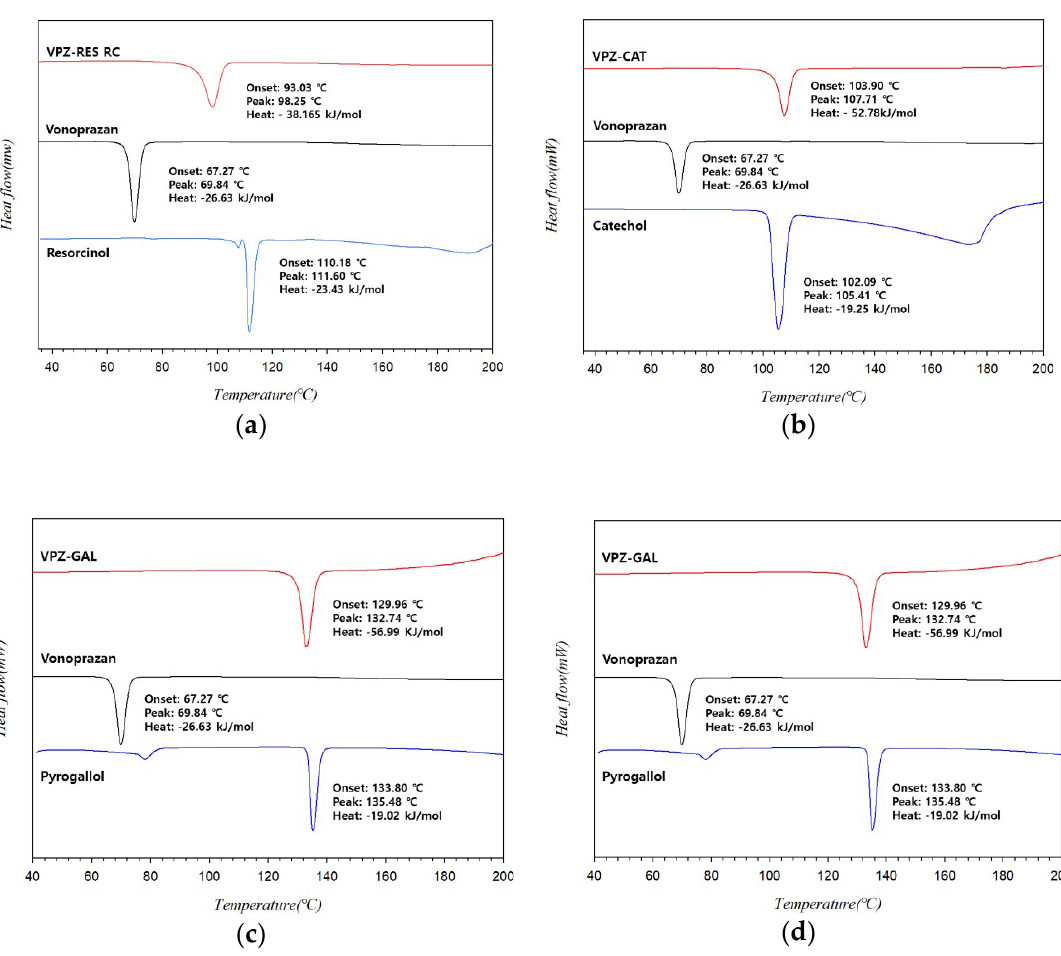
Figure 3. Comparison of the DSC thermograms of ( a ) VPZ-RES, ( b ) VPZ-CAT, ( c ) VPZ-GAL, and ( d ) VPZ- HYQ prepared by RC with their starting materials. ( d ) VPZ- HYQ prepared by RC with their starting